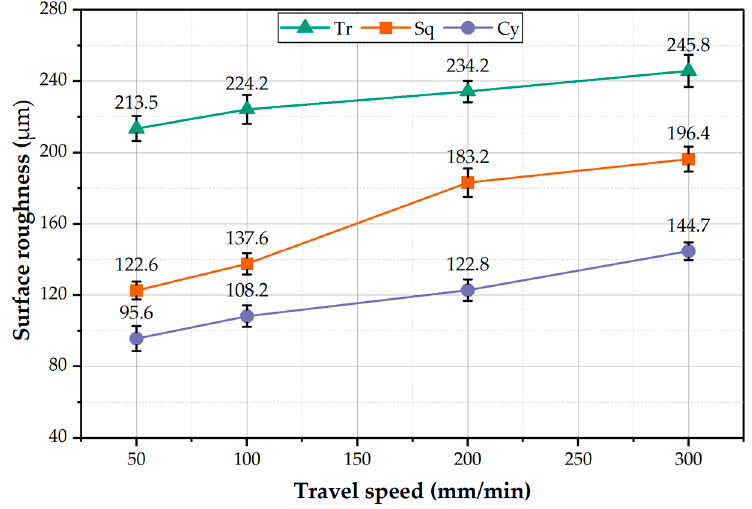
Figure 11. The surface roughness of the BT-FSPed AA1050 as a function of the travel speed for the used pin geometries.